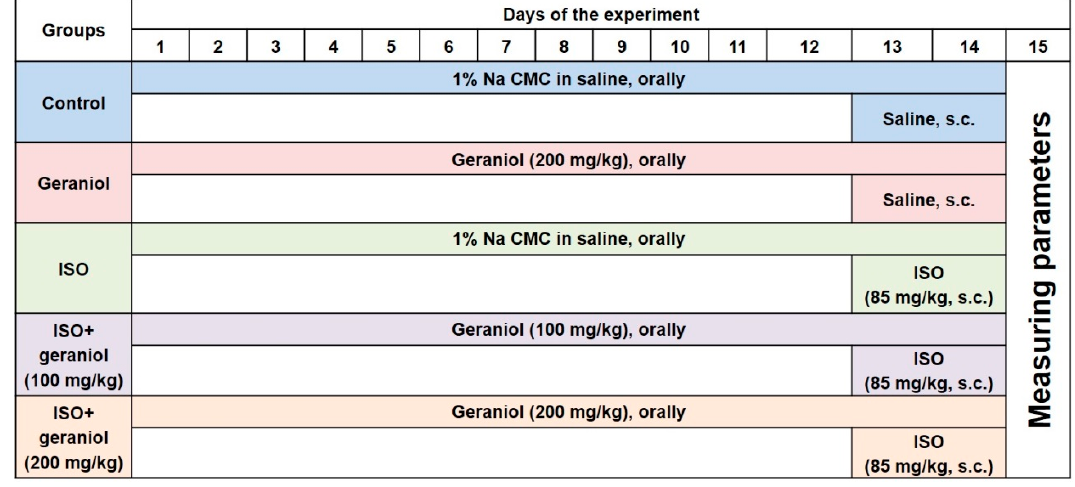
Figure 2. Experimental design showing the di ff erent groups and the respective Figure 2 . Experimental design showing the different groups and the respective treatments.